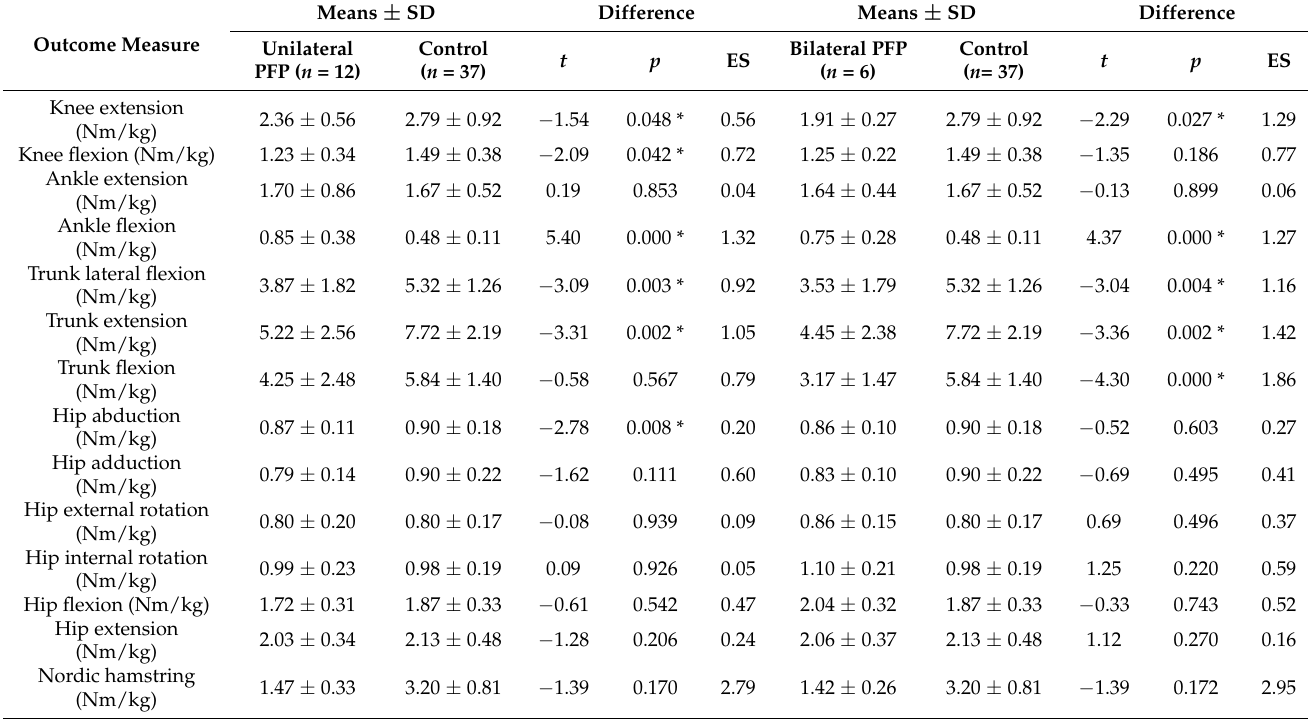
Table 4. Affected leg strength outcome measures and between-group differences.